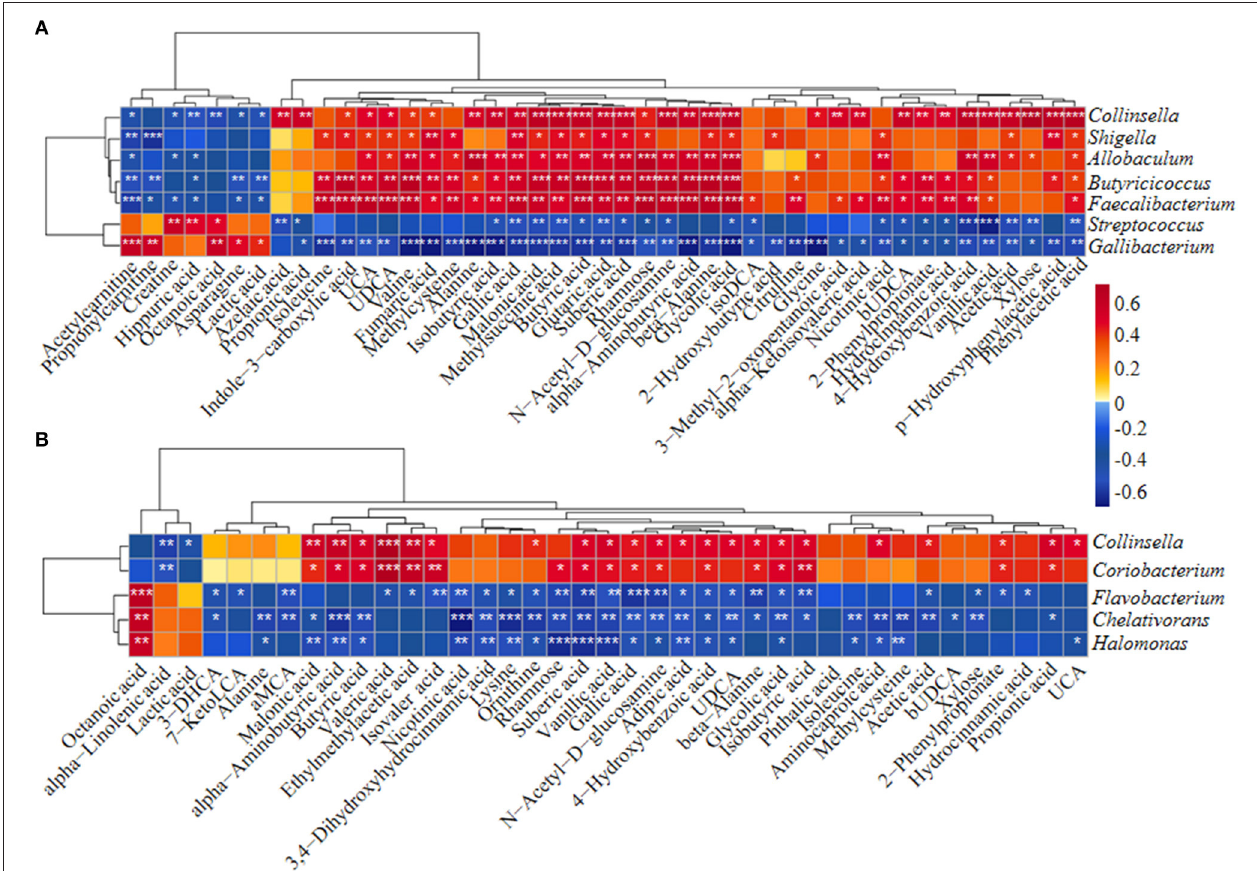
FIGURE 3 | The Spearman correlation between differential gut microbial taxa and their derived metabolites in H_1 vs D_1 (A) and H_2 vs D_2 (B) . Red squares indicated positive correlation and blue squares indicate negative correlation. The intensity of the color was proportional to the strength of Spearman correlation. * p ≤ 0.05, ** p ≤ 0.01, *** p ≤